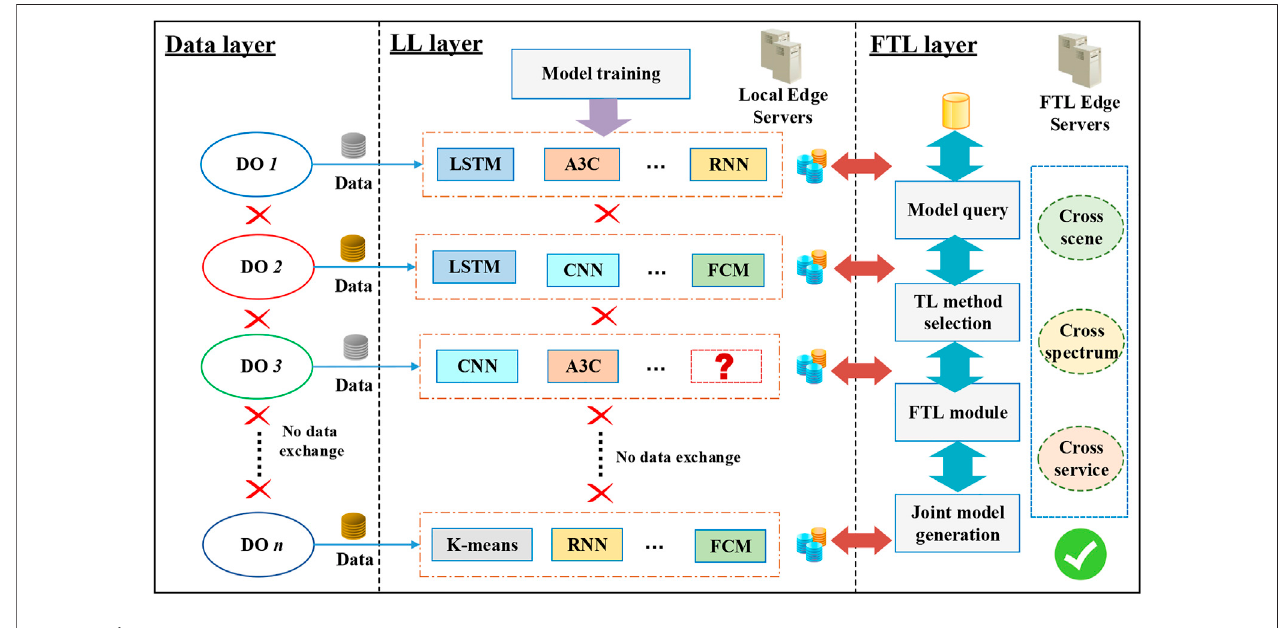
FIGURE 2 | The proposed FTL framework.